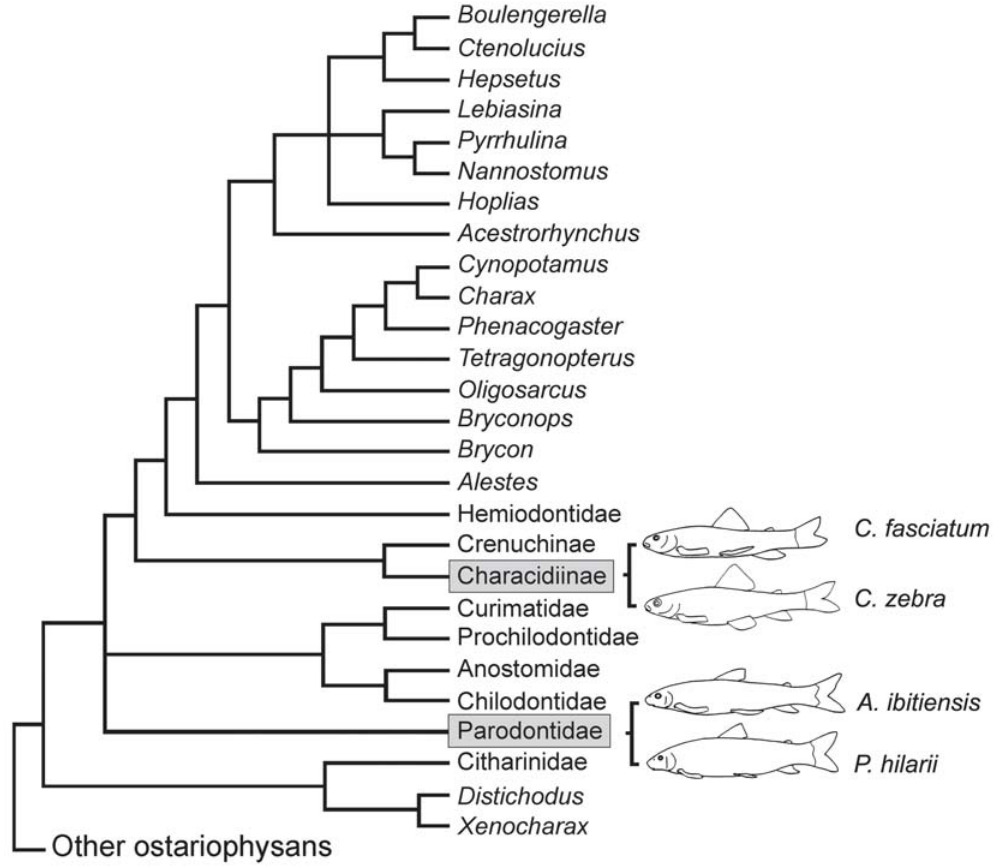
Fig. 4. Cladogram of phylogenetic relationships among selected characiform fishes (modified from Buckup, 1998: 134), show- ing the phylogenetic position of the studied Characidiinae and Parodontidae species, an example of ecomorphological adap- tive convergence in the studied